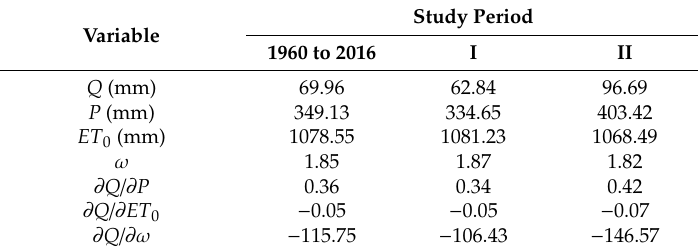
Figure 7. Mann-Kendall test of annual precipitation from 1960 to 2016 ( a ), Mann-Kendall test of annual potential evapotranspiration ( b ), and Cumulative anomaly of the annual surface runoff ( c ) in Qinghai Lake basin. Table 5. Basin characteristic parameters and sensitivity coefficients in each study period.